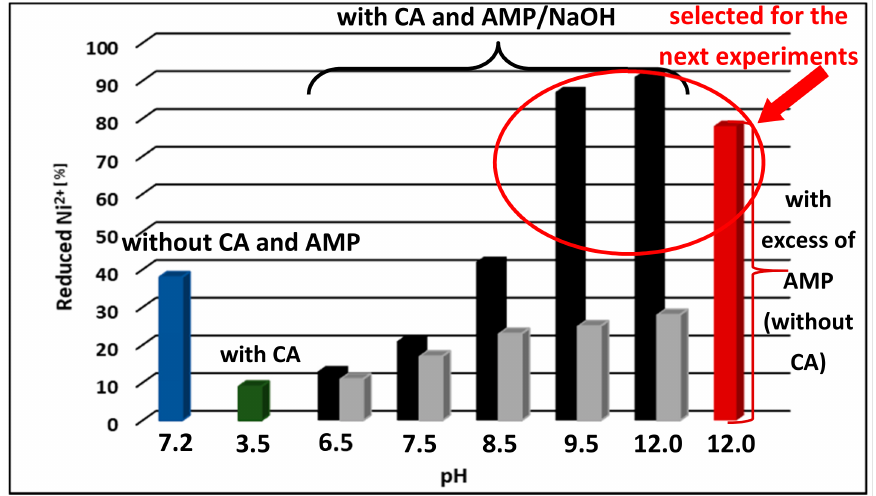
Figure 2. The dependence of the efficiency of Ni 2+ reduction on the conditions of the synthesis process obtained from the EDXRF data: without complexing agents (blue bar); with citric acid (green bar); with complexing agents (black bars), with CA (citric acid) and NaOH (grey bars); with an excess of AMP (amino methyl propanol) (red